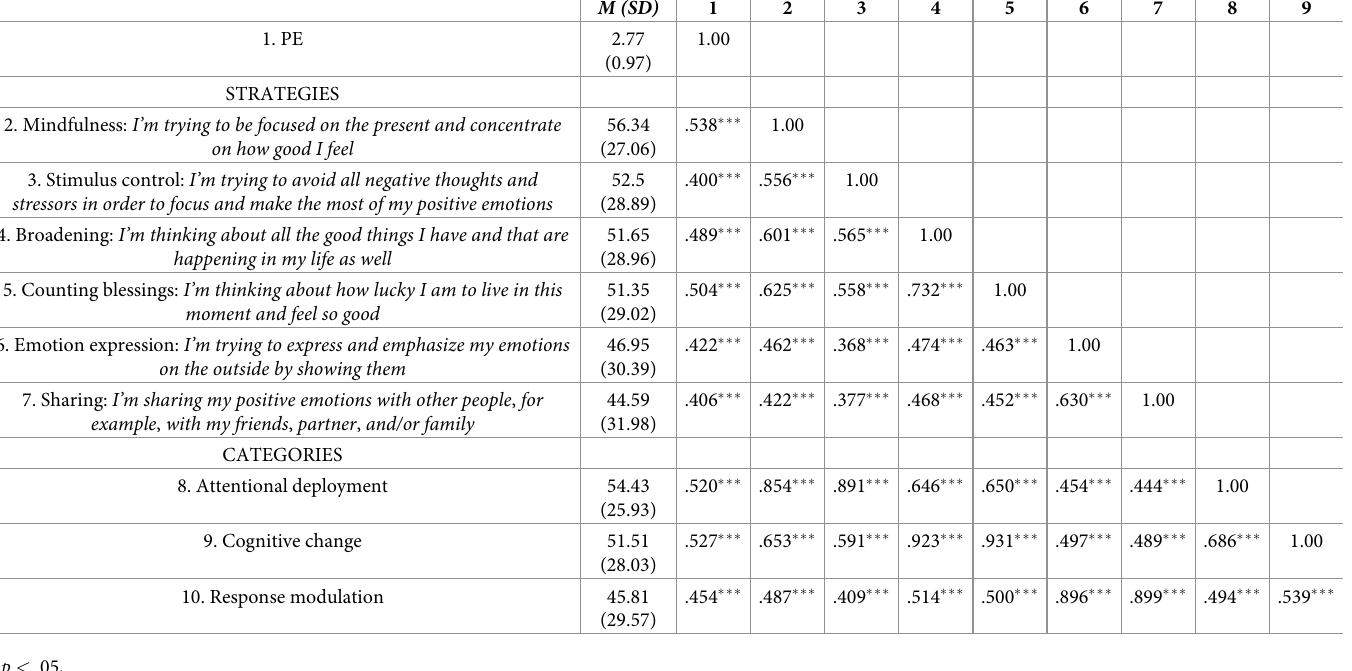
Table 1. Correlations between emotion regulation and PE at the within-individual